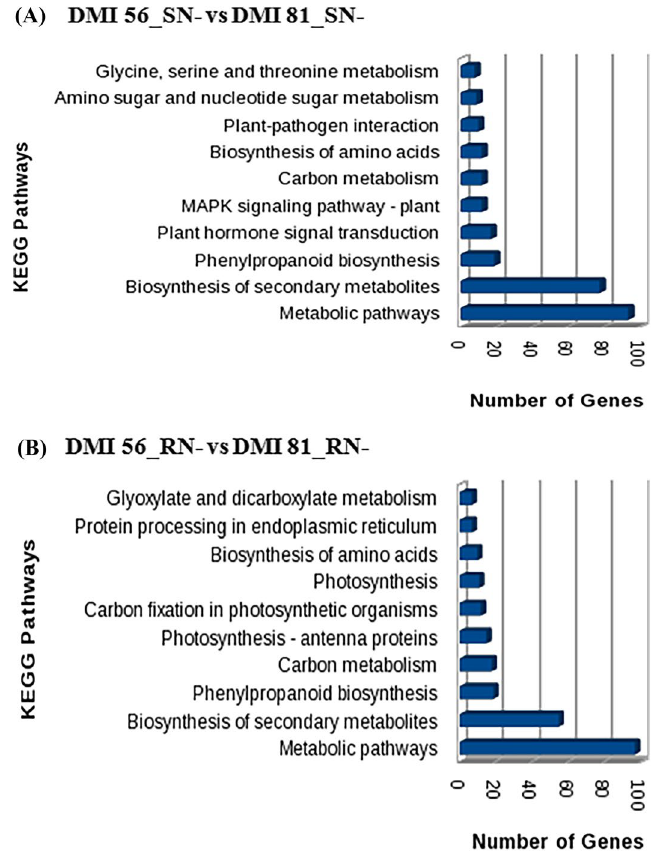
Figure 5. KEGG pathway enrichment analysis of DEGs in comparison ( A ) (DMI 56_SN− vs DMI 81_SN−) and ( B ) (DMI 56_RN− vs DMI 81_RN−) under low-N stress condition. The top 10 pathways from the KEGG enrichment analysis are shown as a bar chart. The terms of the KEGG pathways are depicted on the y-axis. The number of DEGs is shown as the length of the histogram. Letters S, R, and N− represent leaf, root, and nitrogen- deficiency conditions,